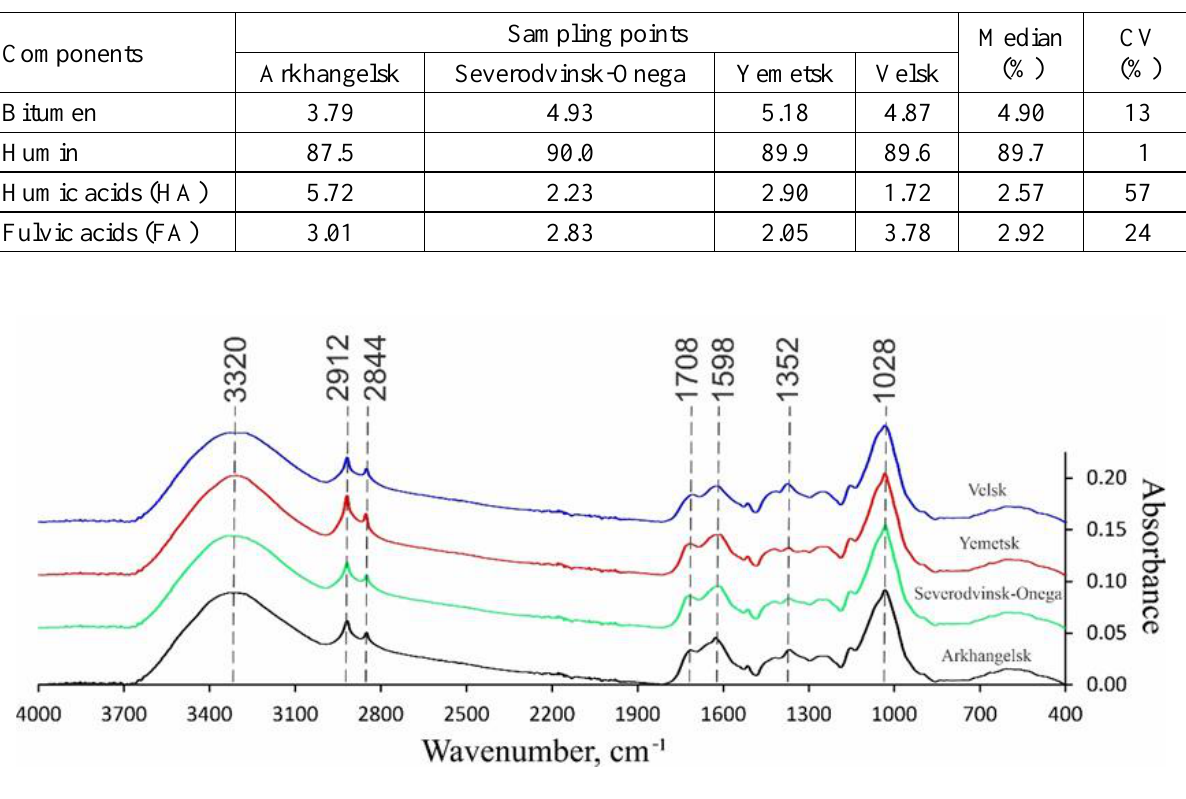
Table 2. The average proportions (%) of components, median values and coefficients of variation (CV) in the studied soils.